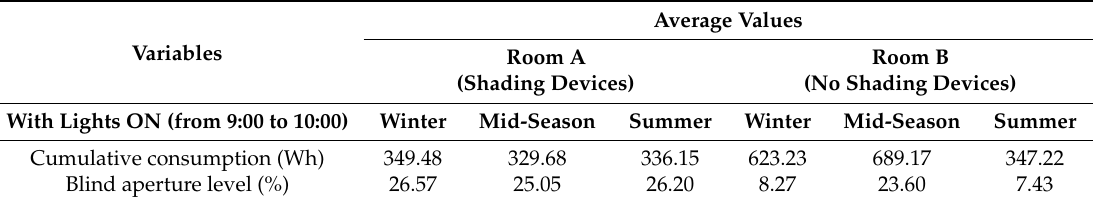
Table 9. Analysis of average values (Wh and Blind level) when both classrooms simultaneously recorded lighting consumption, during the first hour of class (9:00 to 10:00). Variables